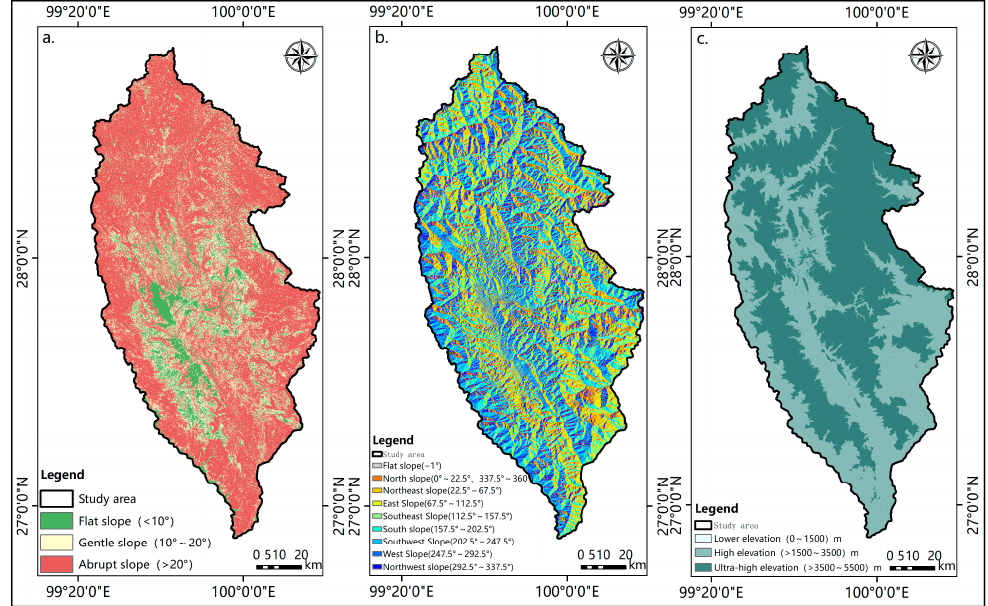
Figure 3. Slope, aspect, and elevation maps of the study area. ( a ) Slope; ( b ) aspect; ( c ) elevation.